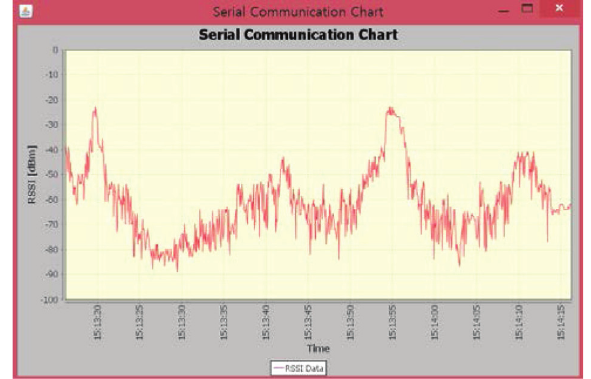
Fig. 3. A screenshot of Java application for plotting real-time RSSI measurement through serial port at a base station